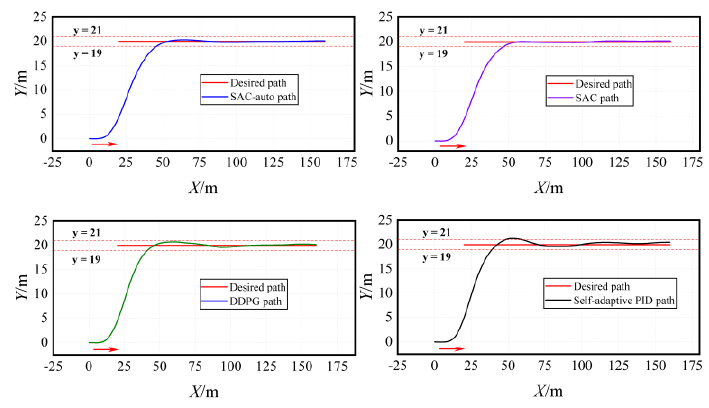
Figure 11. Path following. Figure 11. Path